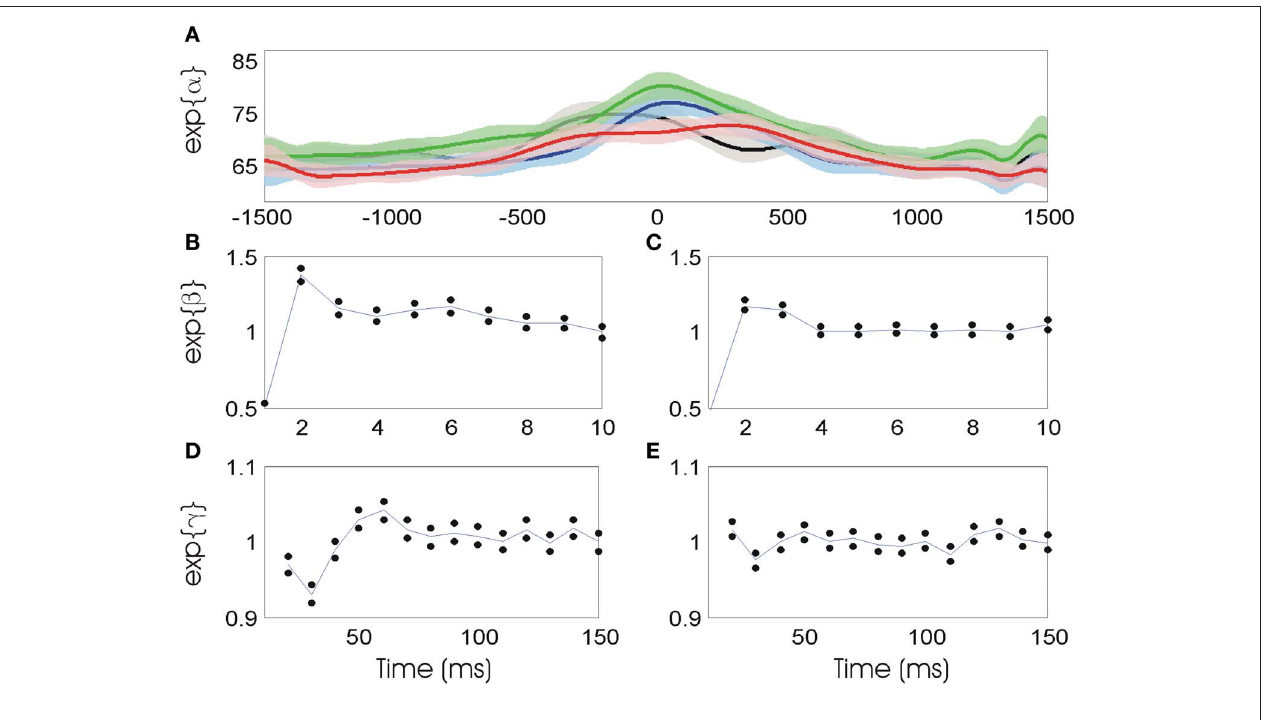
FIGURE 4 | (A) Stimulus related firing rate estimates in each of four movement directions (black—right; blue—down; green—left; red—up). (B) Short-term history (0–10ms) parameters prior to movement. Blue line represents parameter estimates, black dots